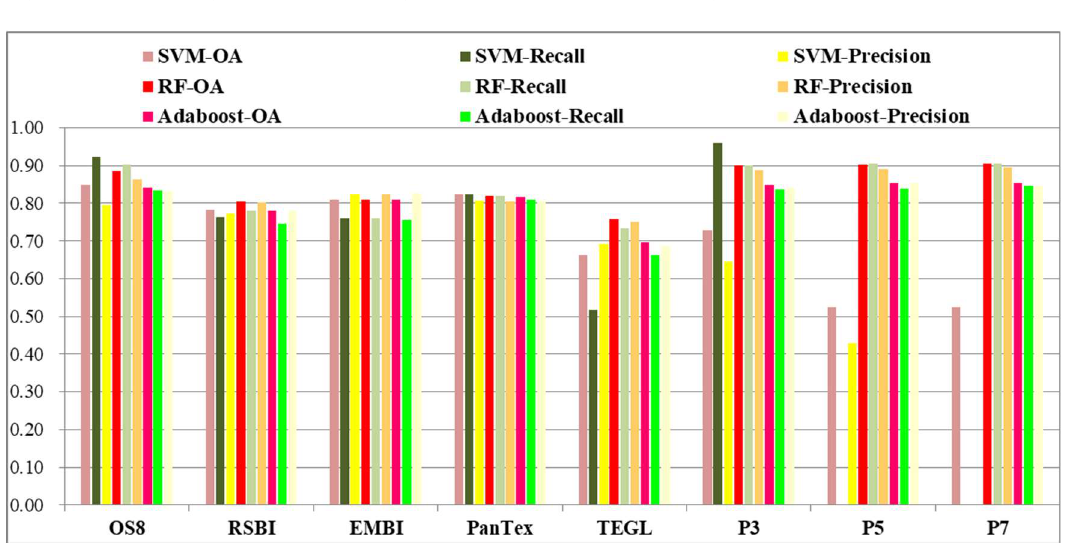
Figure 9. Classification accuracies of the built-up area based on feature engineering. Table 6. Accuracy evaluation based on feature learning.